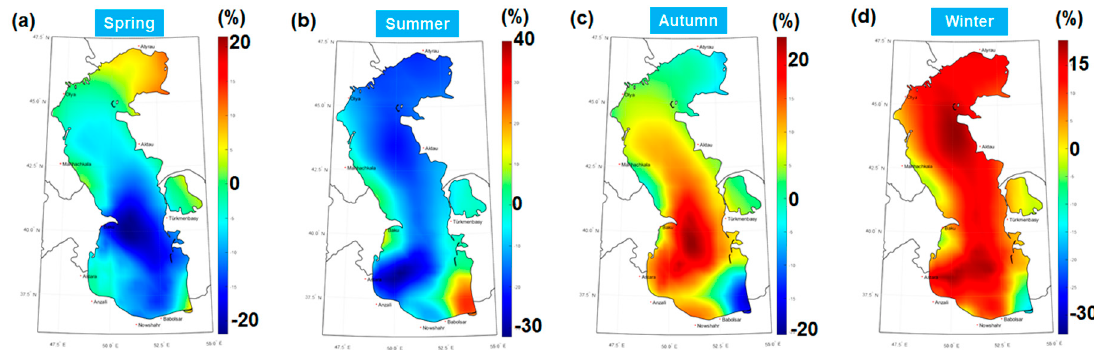
Figure 4. The spatial differences (in %) between the total time data and the four main seasons. The results are reported for the U 80 parameter (average values) considering the 20-year time interval of ERA-Interim data, where: ( a ) spring; ( b ) summer; ( c ) autumn and ( d ) winter.